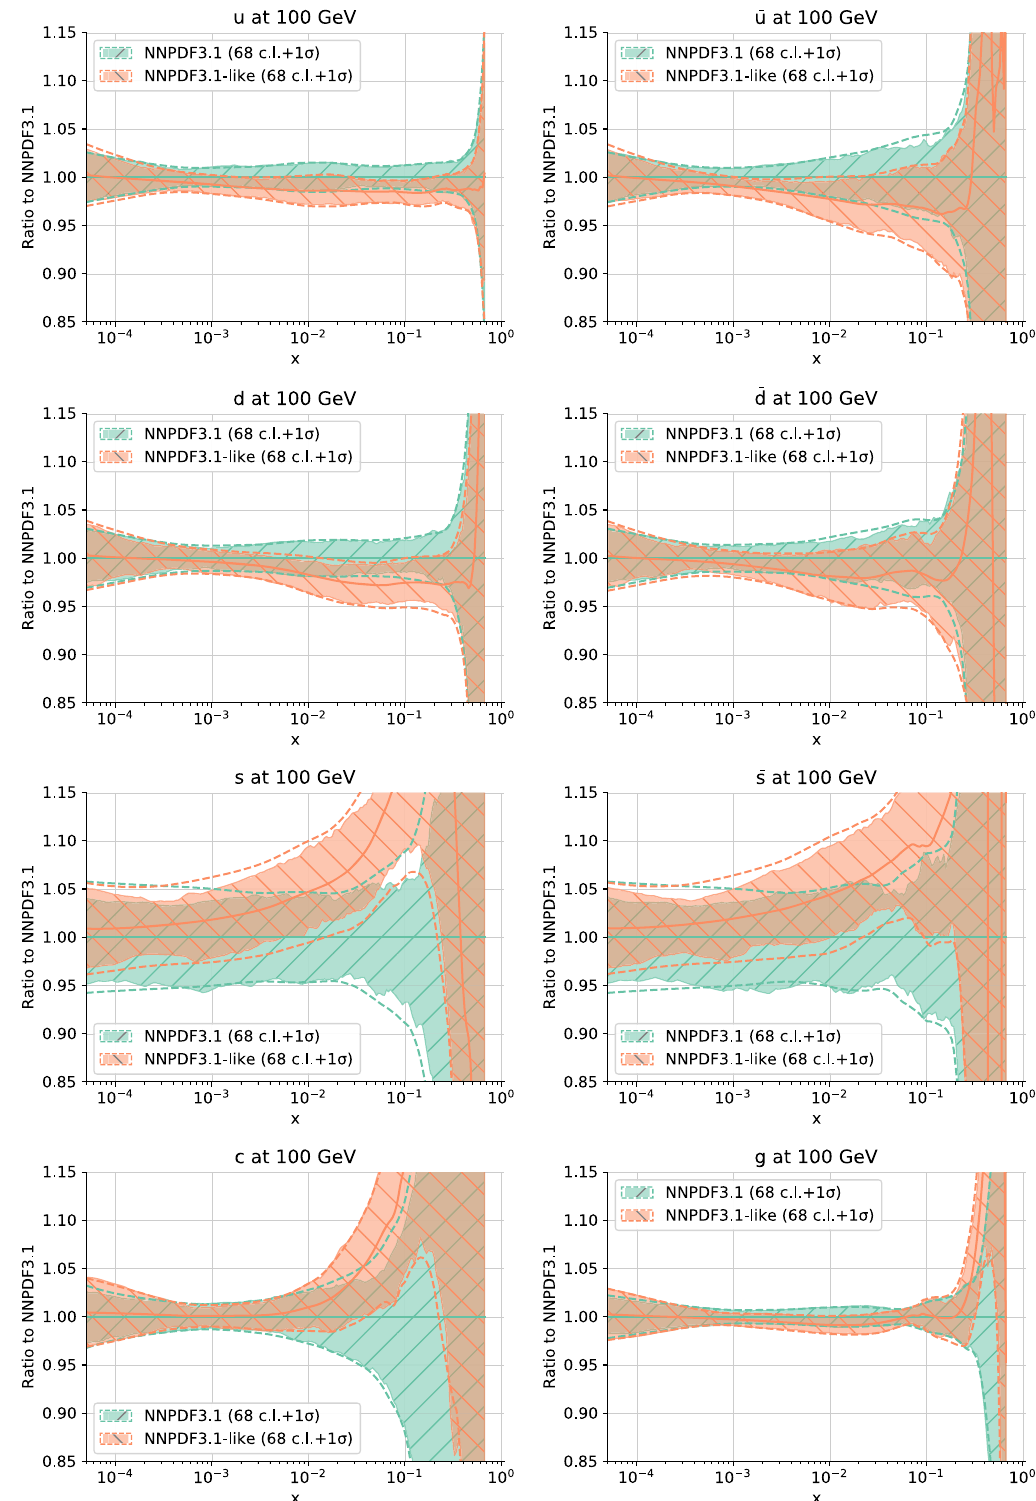
Fig. 31 The up, antiup, down, antidown, strange, antistrange, charm and gluon PDFs from NNPDF3.1 and from a fit based on the same NNPDF3.1 methodology but on the NNPDF3.1-like dataset defined in